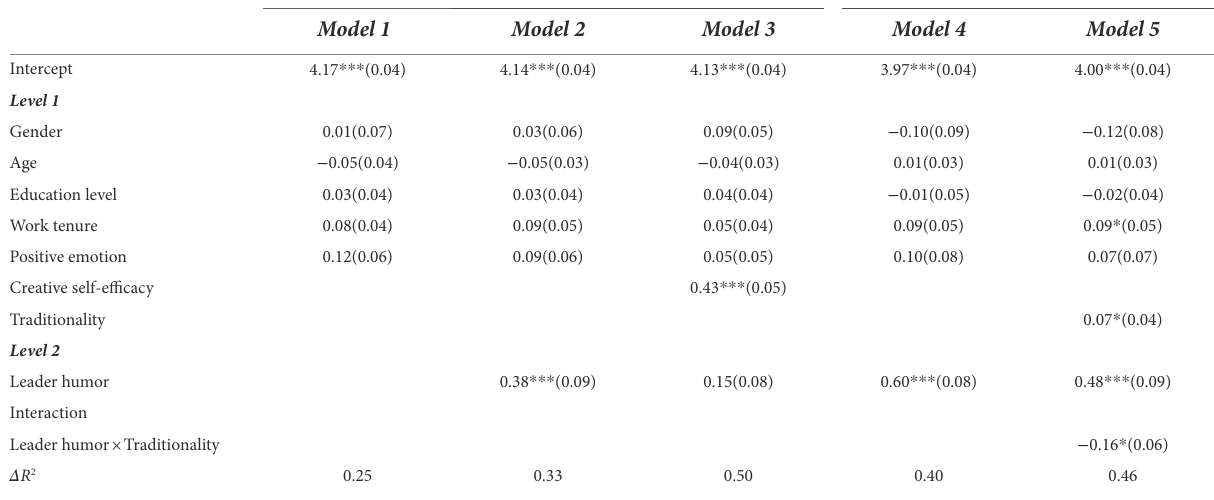
TABLE 4 Results of hierarchical linear